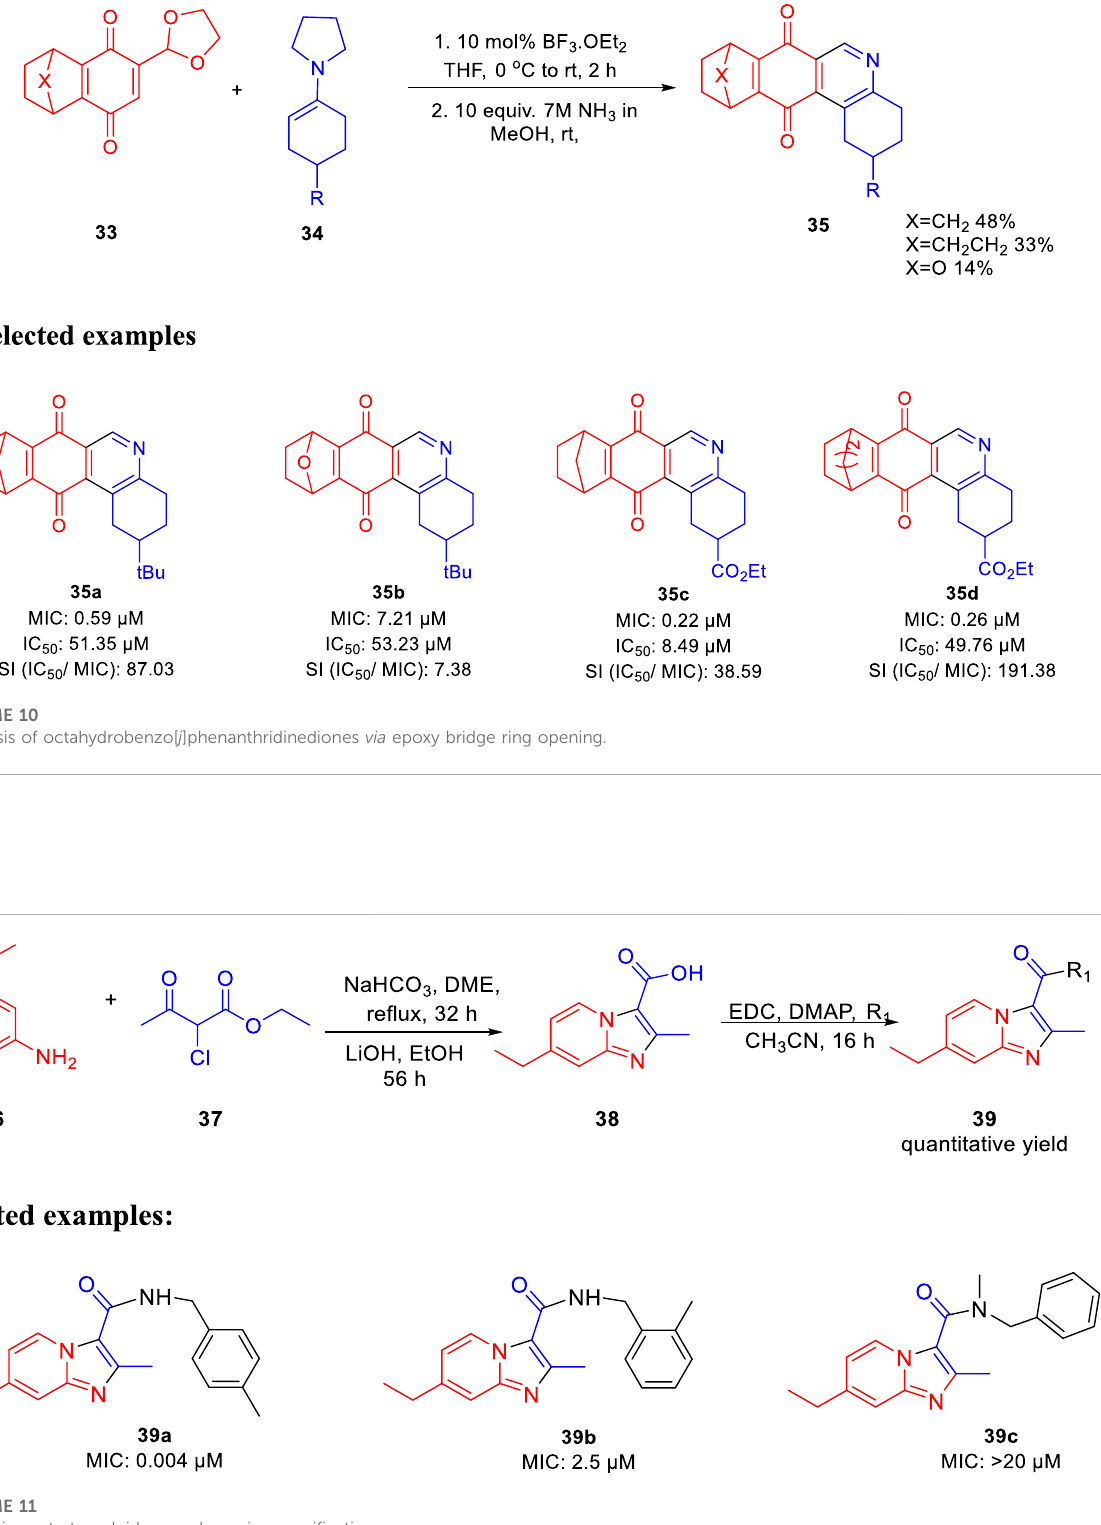
SCHEME 11 Synthetic route to zolpidem analogs via saponi fi